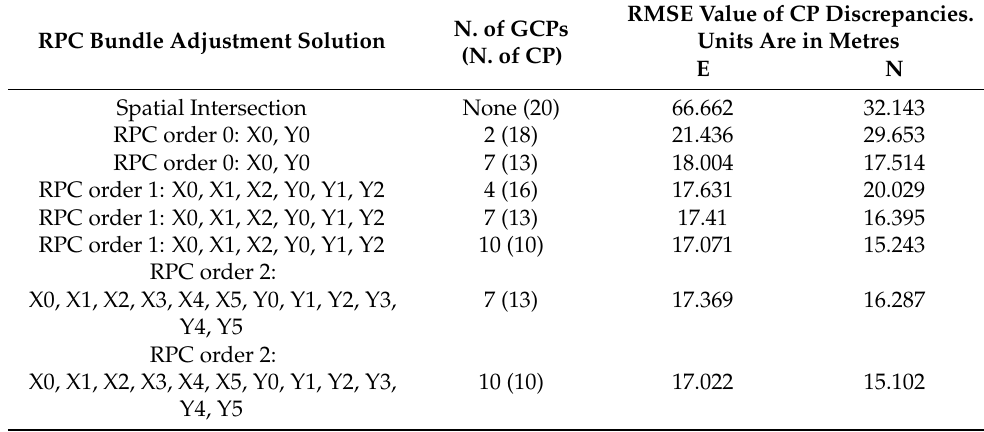
Table A7. Results of RPC bundle adjustment with bias compensation for right strip in N-S direction, case